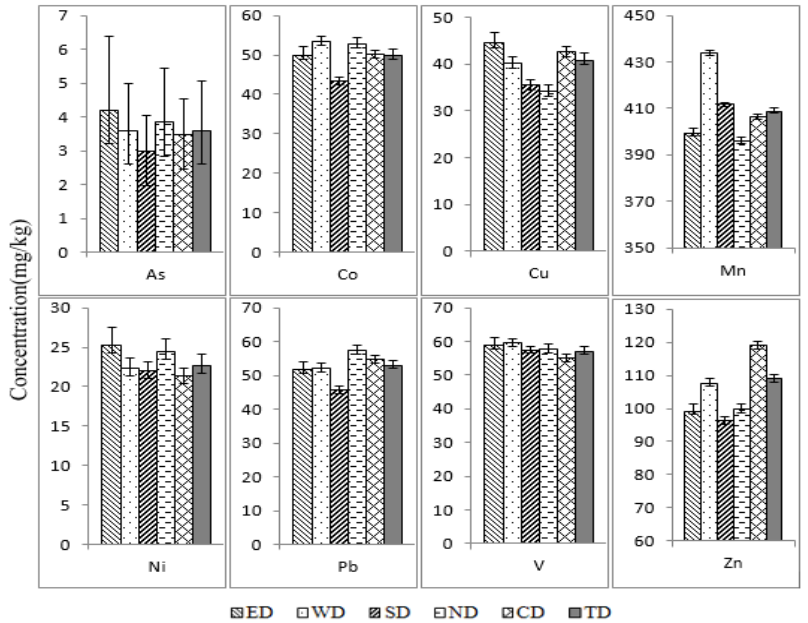
Figure 2. Concentrations of ESEs in smaller than 100 μm street dust particles from Xining (ED: East District; WD: West District; SD: South District; ND: North District; CD: Central District; TD: Total